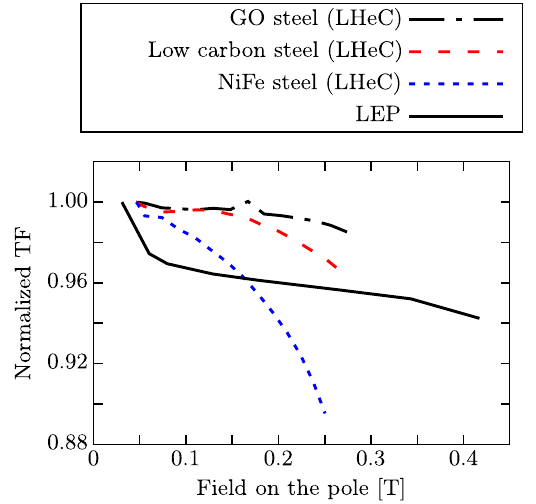
FIG. 8. Normalized center transfer function of LHeC dipole prototypes ( λ ¼ 0 . 33 ) and LEP dipoles ( λ ¼ 0 . 27 ) over iron field ¼ B B = λ [42]. pole gap